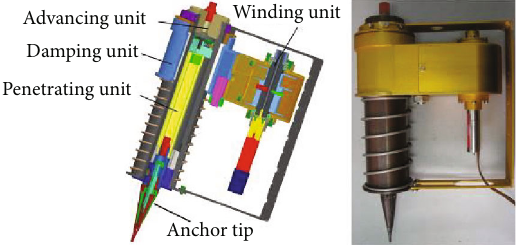
Figure 1: Schematics of anchoring